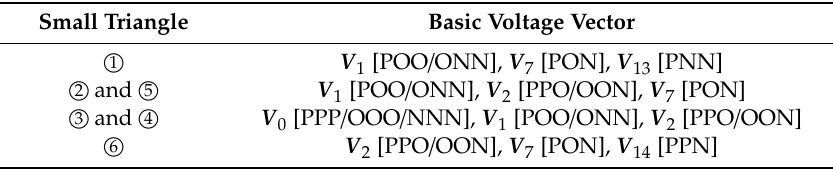
Table 2. Basic vectors used to synthesize V ref in each triangle of sector Z